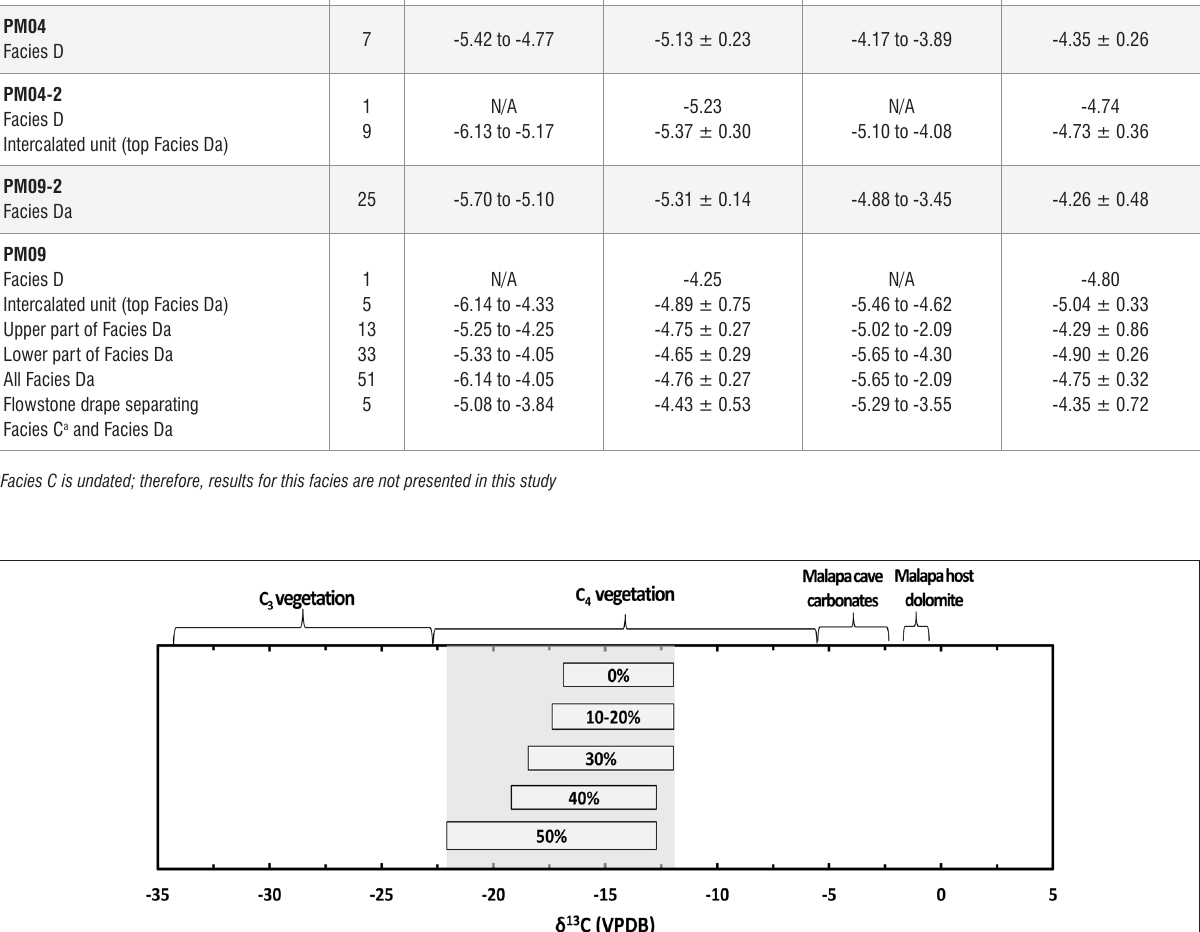
vegetation when 4